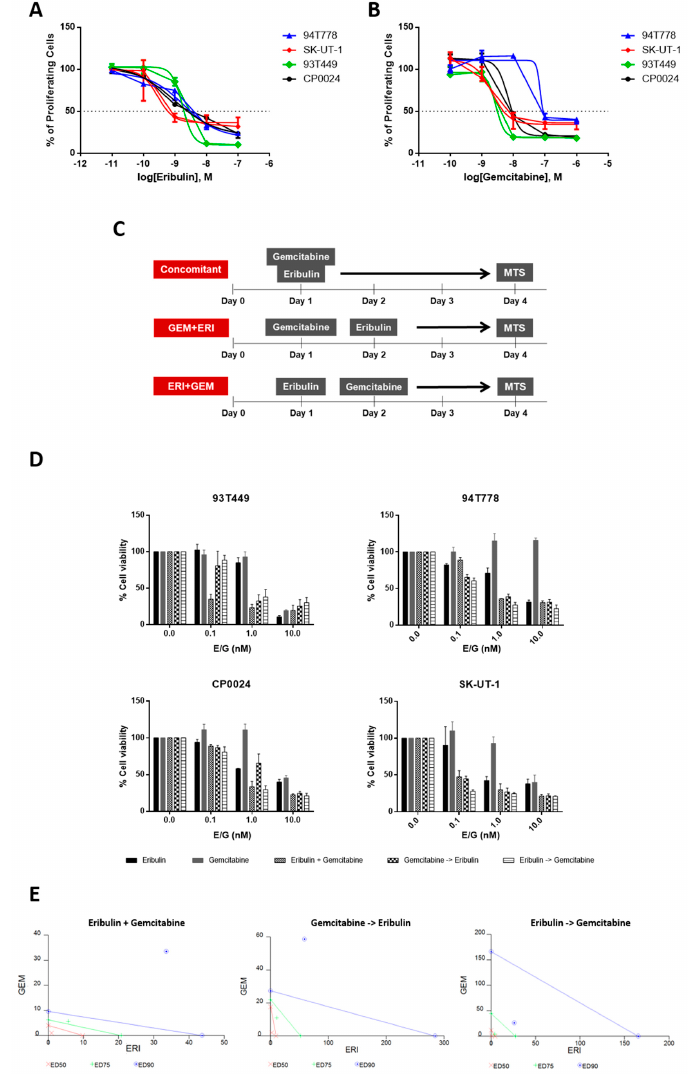
Figure 1. Cell viability after treatment with eribulin, gemcitabine or combinations in L − arcoma cell lines. ( A ) Cell viability measured at 72 h by MTS after treatment with eribulin at concentrations in